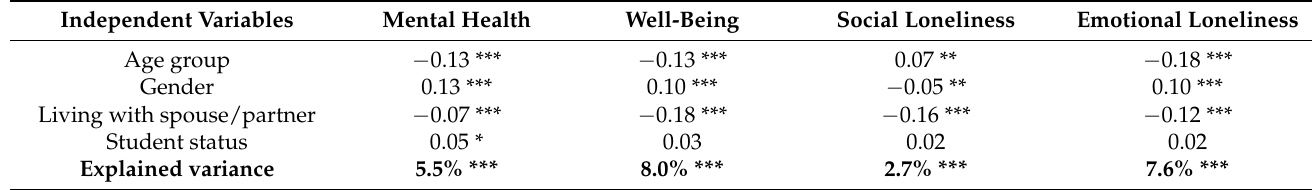
Table 3. Associations with mental health outcomes.